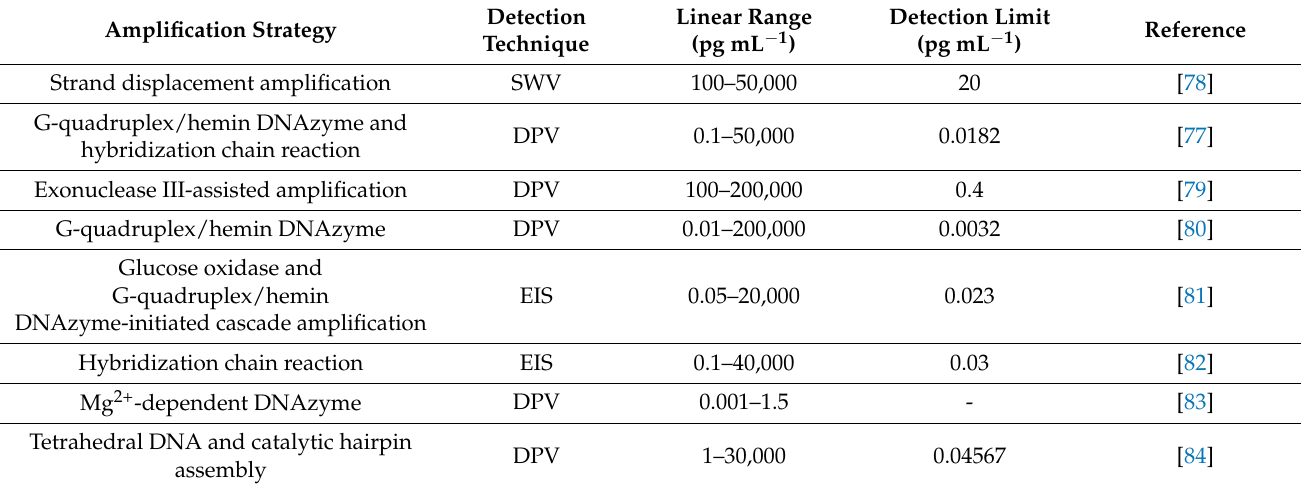
Table 2. Performance comparison of recently reported electrochemical aptasensors for CEA. Amplification Strategy